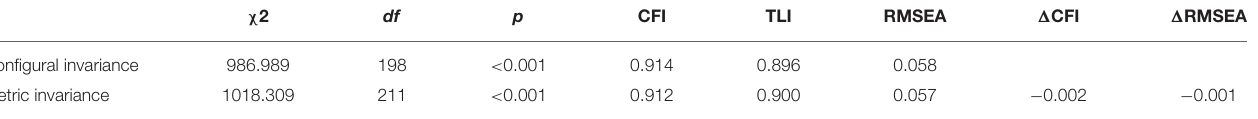
TABLE 10 | Evaluations of measurement